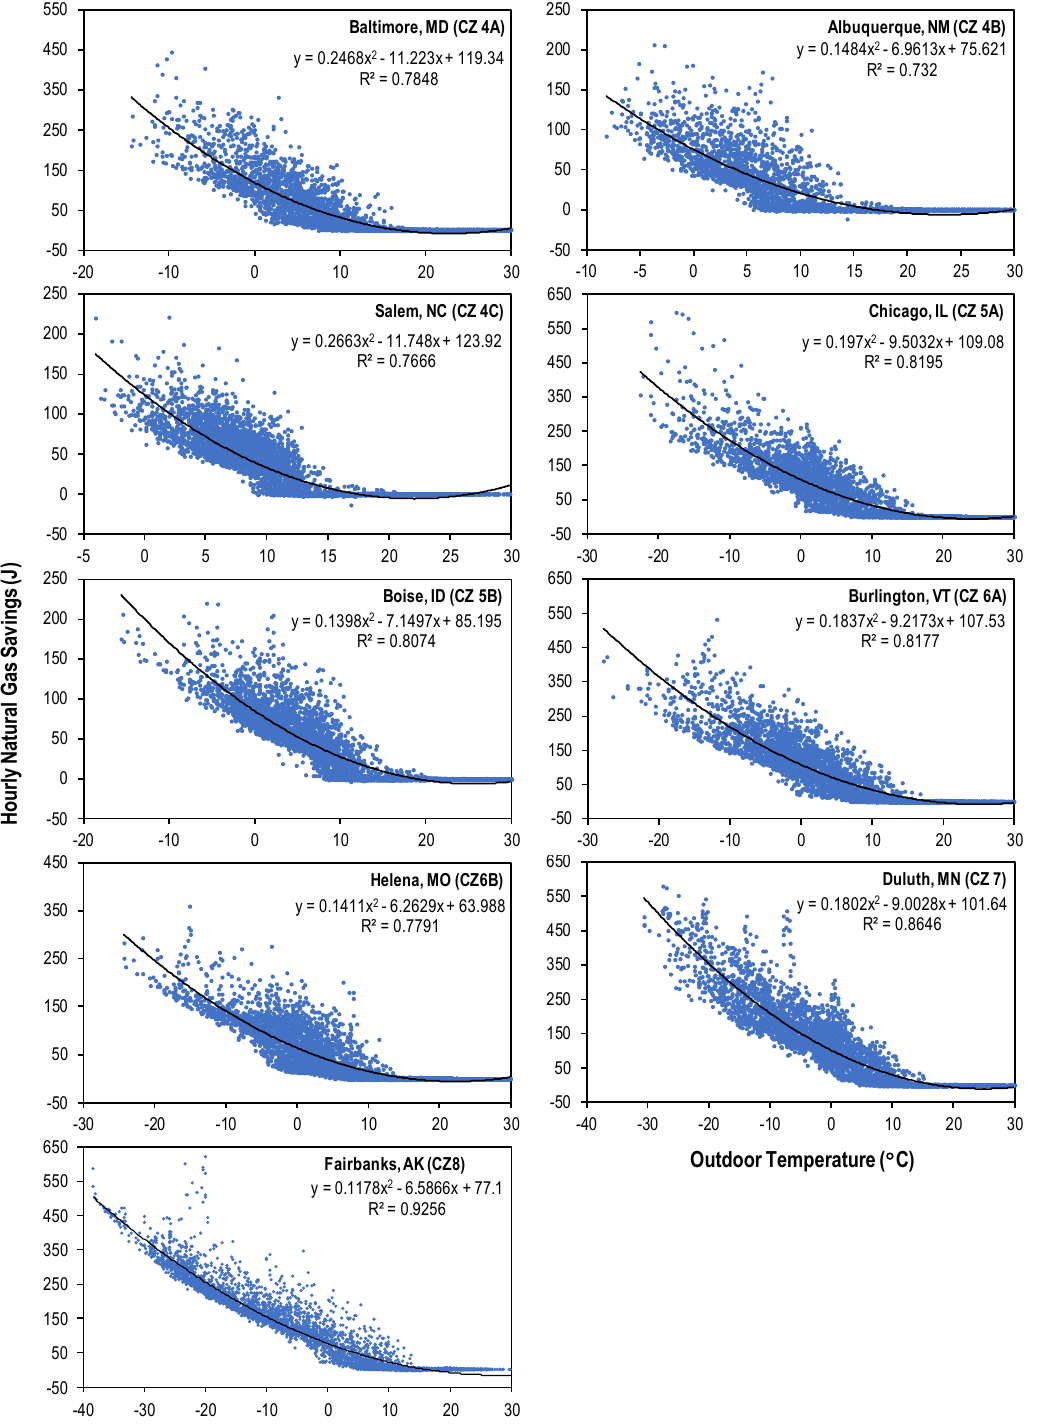
Figure 4. Correlation between outdoor air temperature and heating energy savings in nine cities representative of climate zones 4–8.